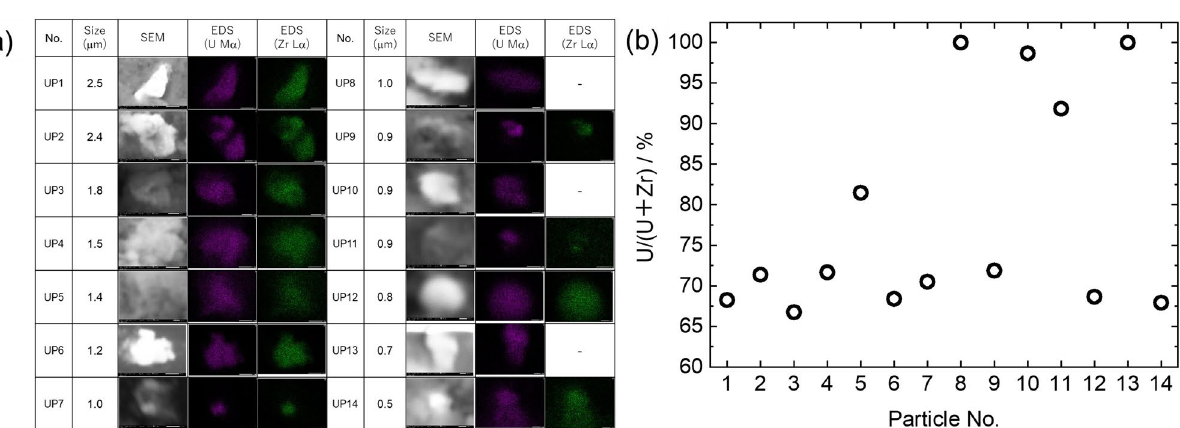
Figure 2. Example of the detection of U particles using SEM–EDX. ( a ) Optical image and ( b ) back-scattered electron detection (BED) image of U particle (UP1) on Fe particles. ( c ) The BED image at high magnification indicated by the blue square in ( b ). ( d ) EDS spectrum of the area indicated by the red square in ( a ). ( e ) Elemental maps of the major content in the U particles.